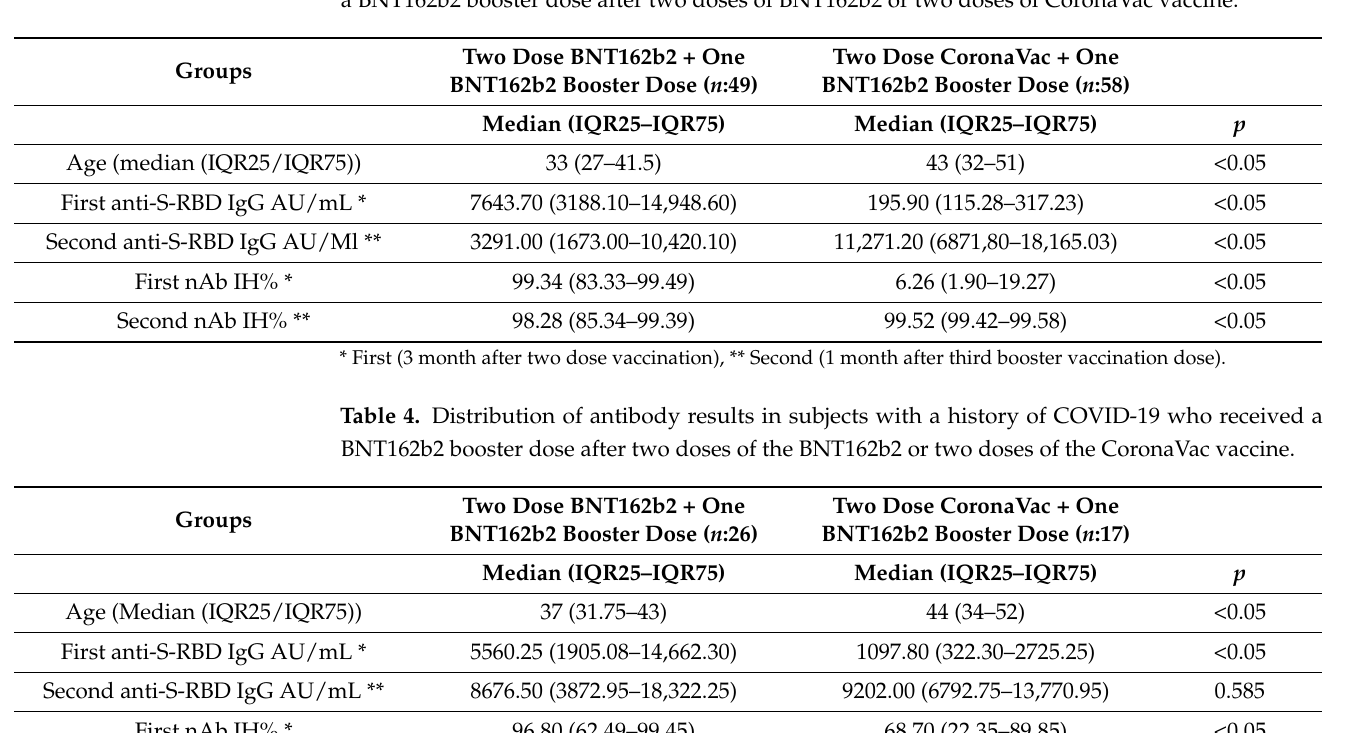
Table 3. Distribution of antibody results in subjects without prior history of COVID-19 who received a BNT162b2 booster dose after two doses of BNT162b2 or two doses of CoronaVac vaccine.